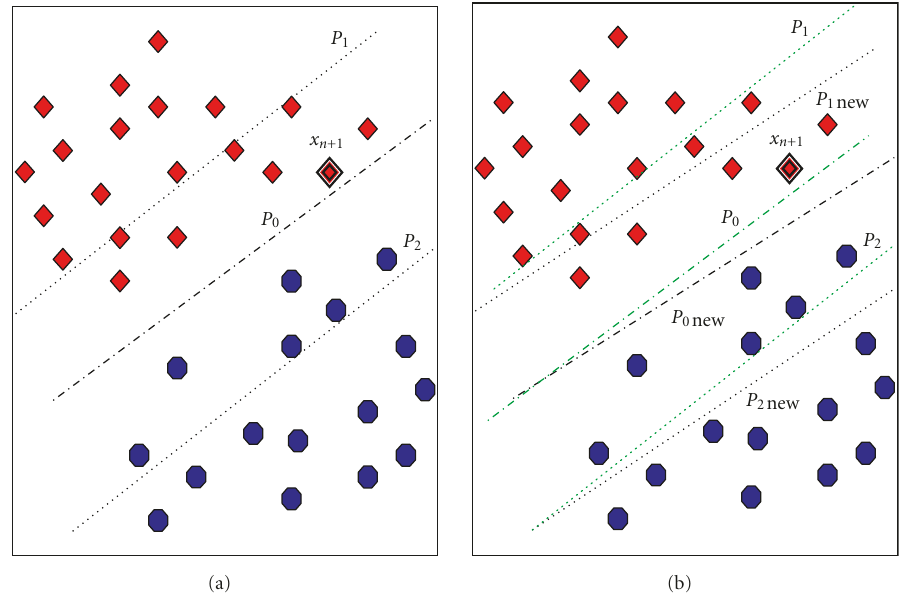
Figure 2: E ff ect of x N +1 on plane orientation in case a system parameter update is needed.